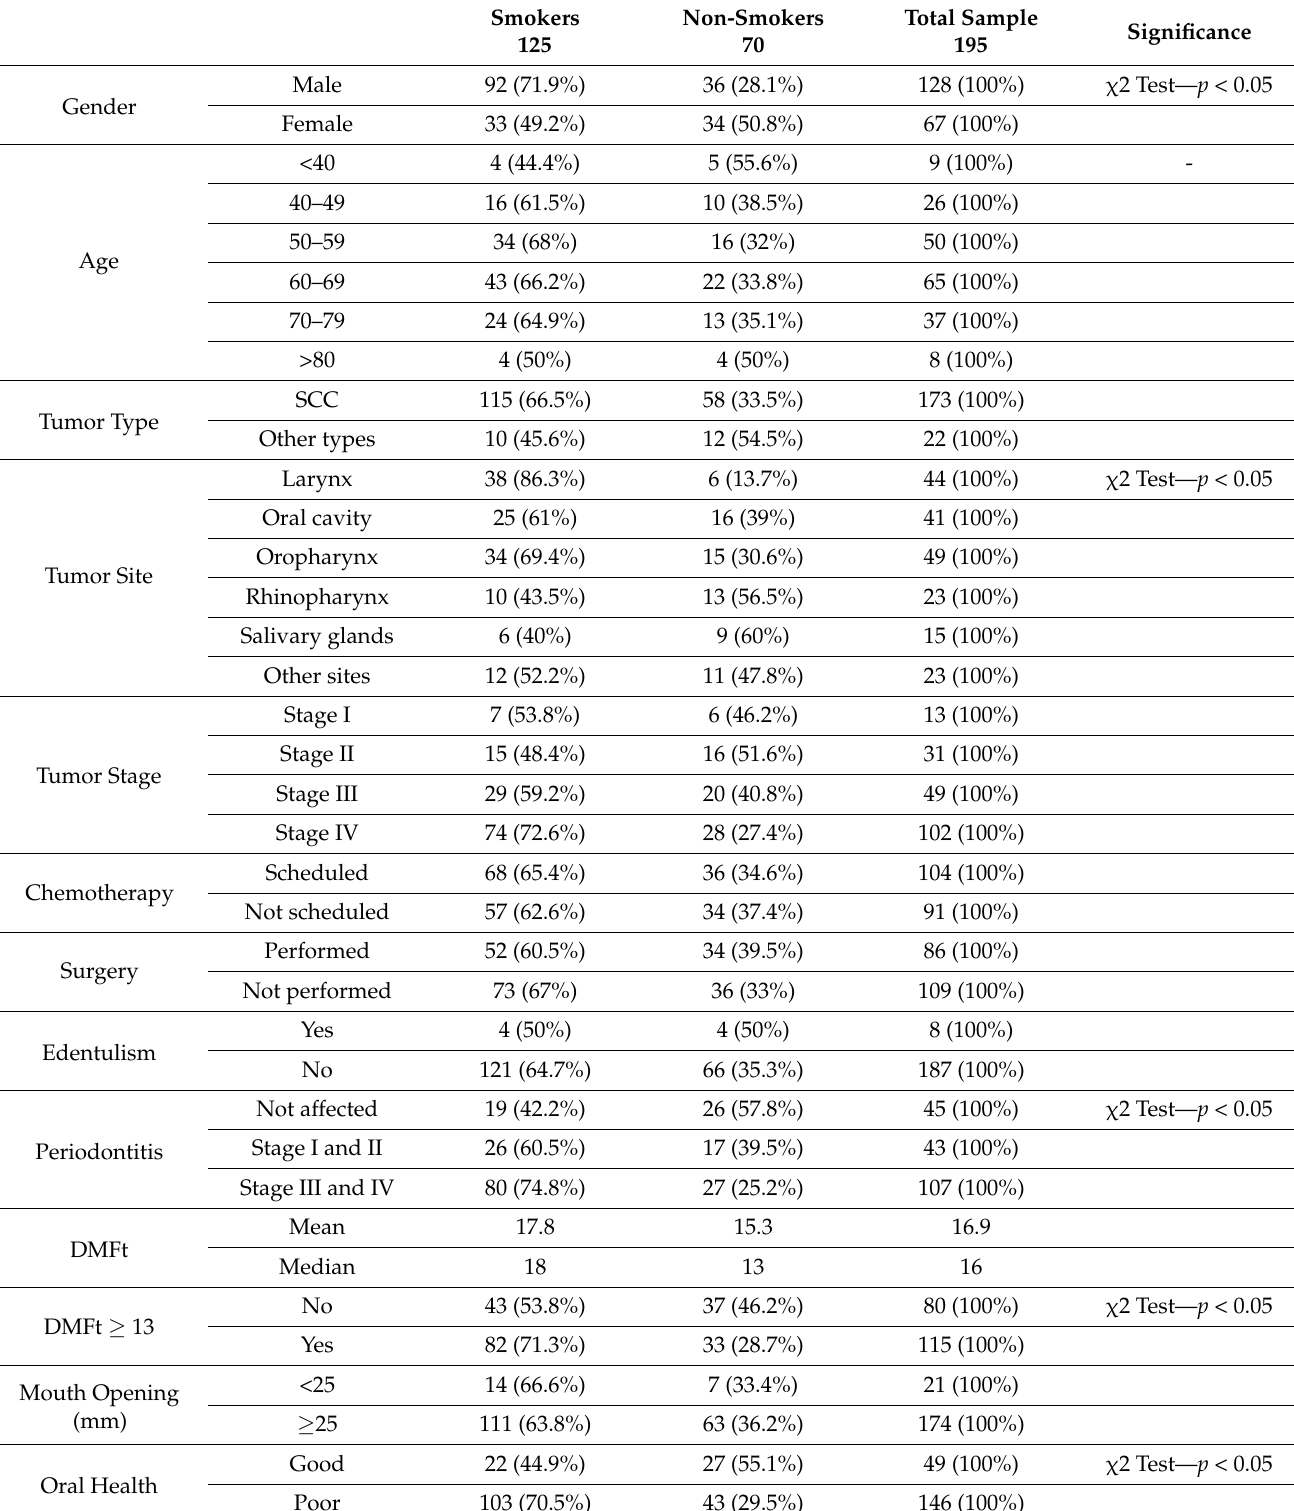
Table 4. General and oral health characteristics of the studied population, according to the habit of